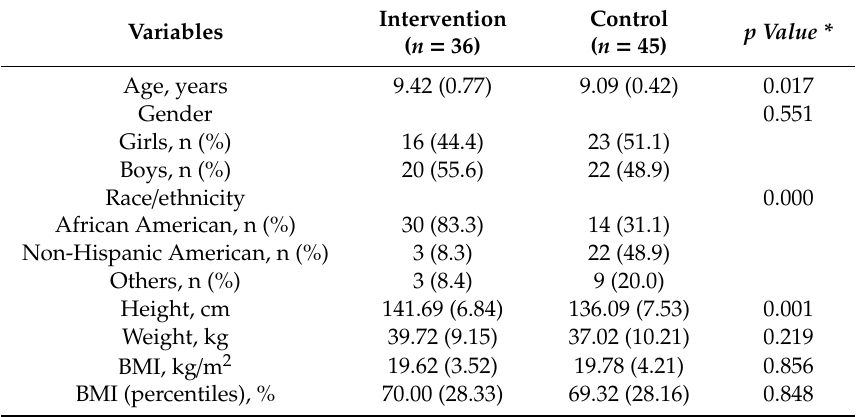
Table 1. Baseline demographic characteristics of